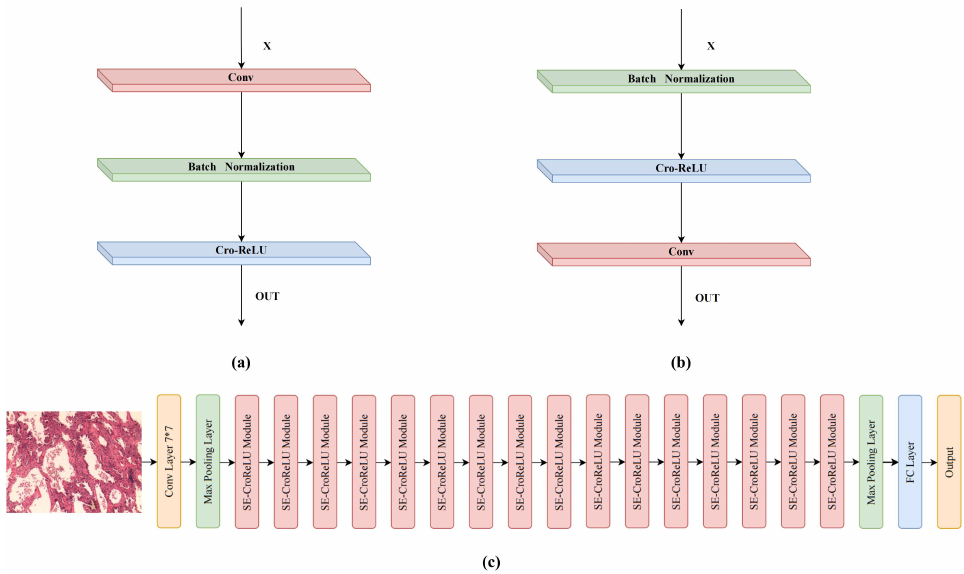
Figure 4. In combination with CroRelu’s convolutional network module: ( a ) Conv-ReLU:Conv-BN- AF; ( b ) CroReLU-Conv: BN-AF- Conv; ( c ) Overall architecture of